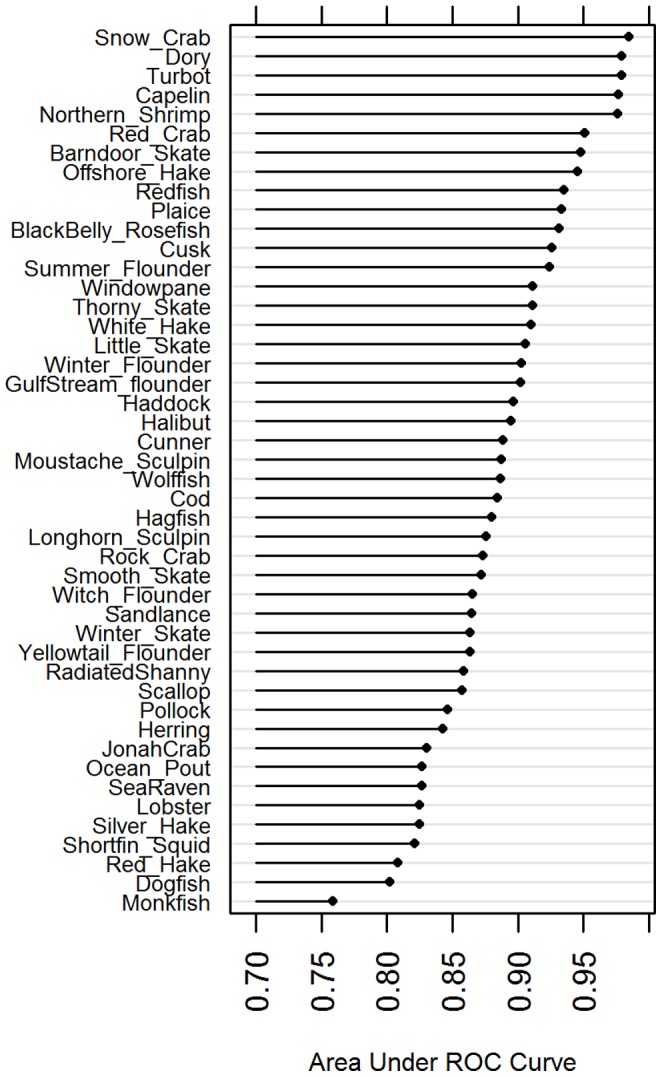
Area Under Receiving Operating Curve (AUC).Expected Accuracy (of classification) of GAM model fit for each species, compared to the observations. An AUC value of 1 would indicate that predicted values resulted in a completely accurate classification of observations. For all but one species, the model was able to accurately classify >80% probability of occurrence.